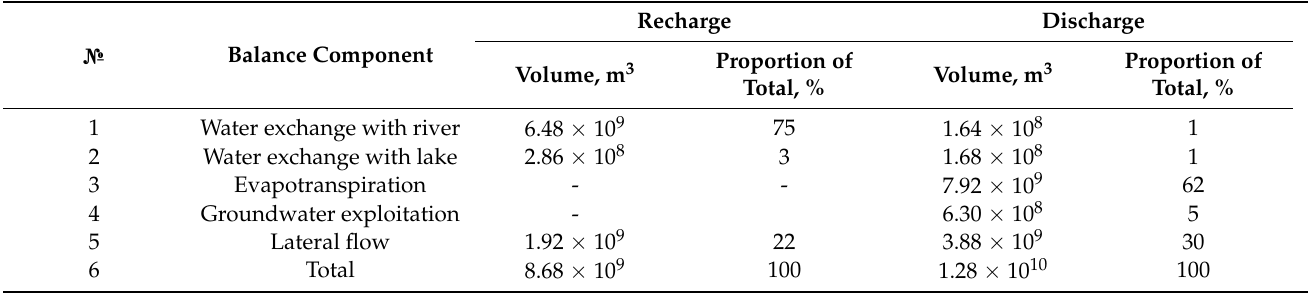
Table 4. Groundwater balance within the model domain from 1 January 2000 to 31 December